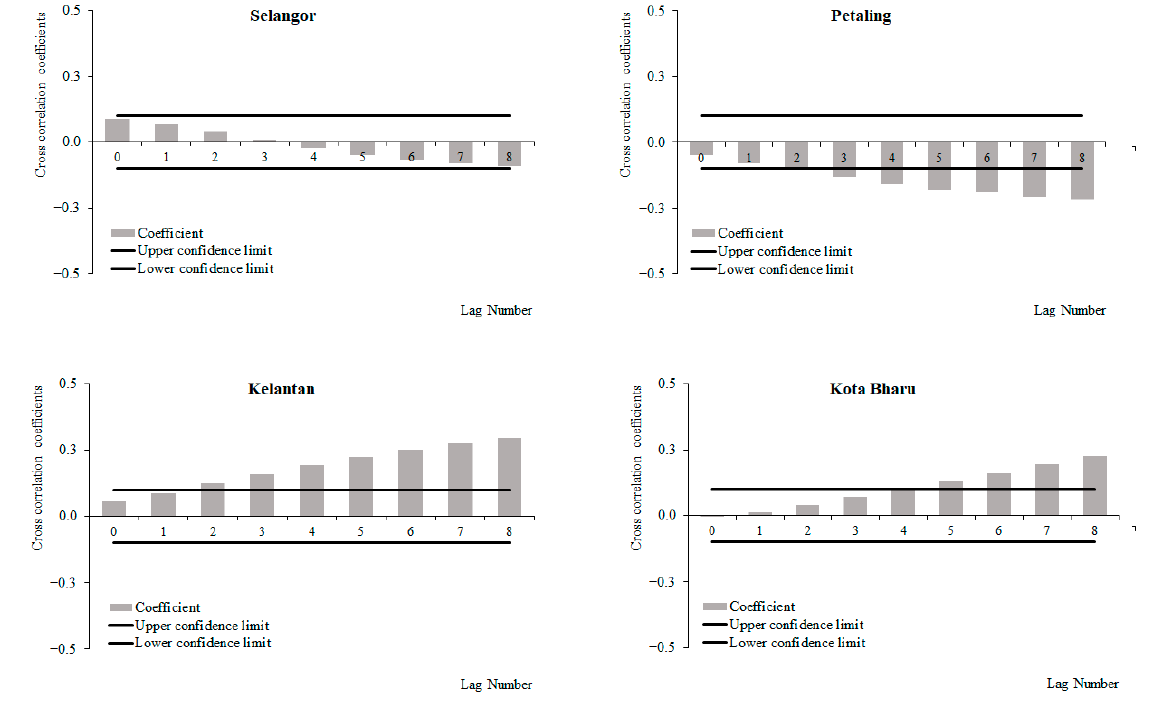
Figure 9. Cross-correlation function between dengue cases and temperature in Selangor, Petaling, Kelantan and Kota Baharu, 2011 to 2019.